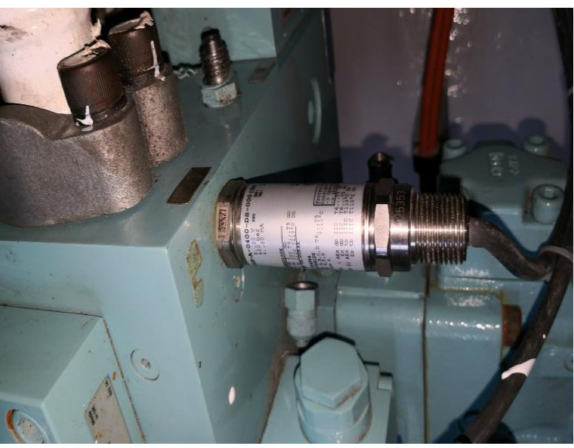
Figure 10. Pressure